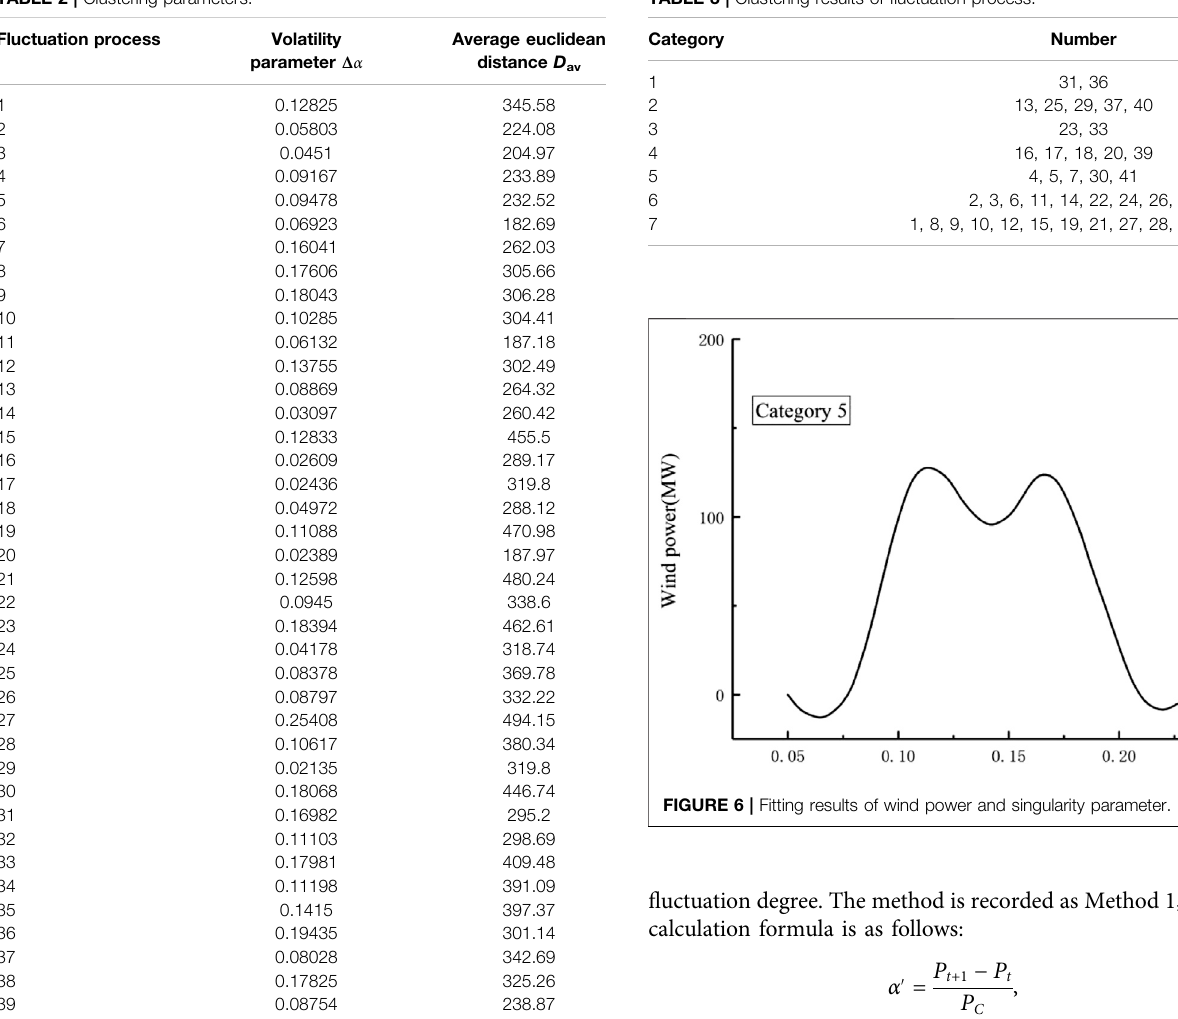
TABLE 2 | Clustering